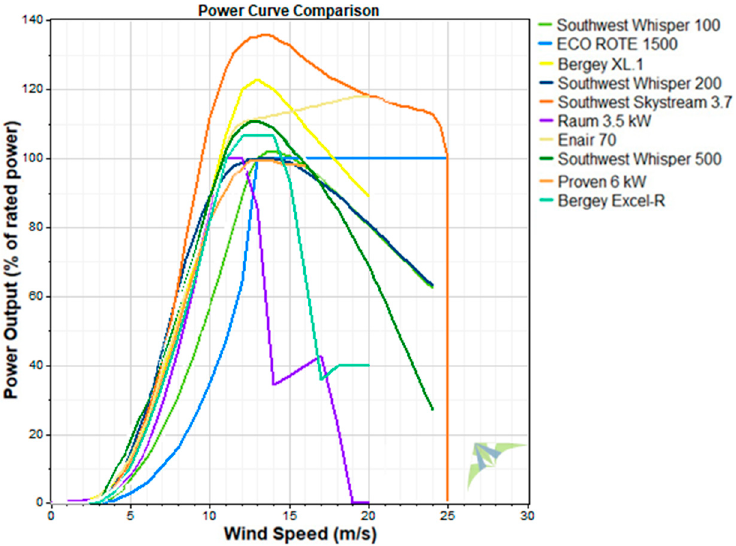
Figure 20. Power output comparison for the wind turbines selected for comparative analysis.